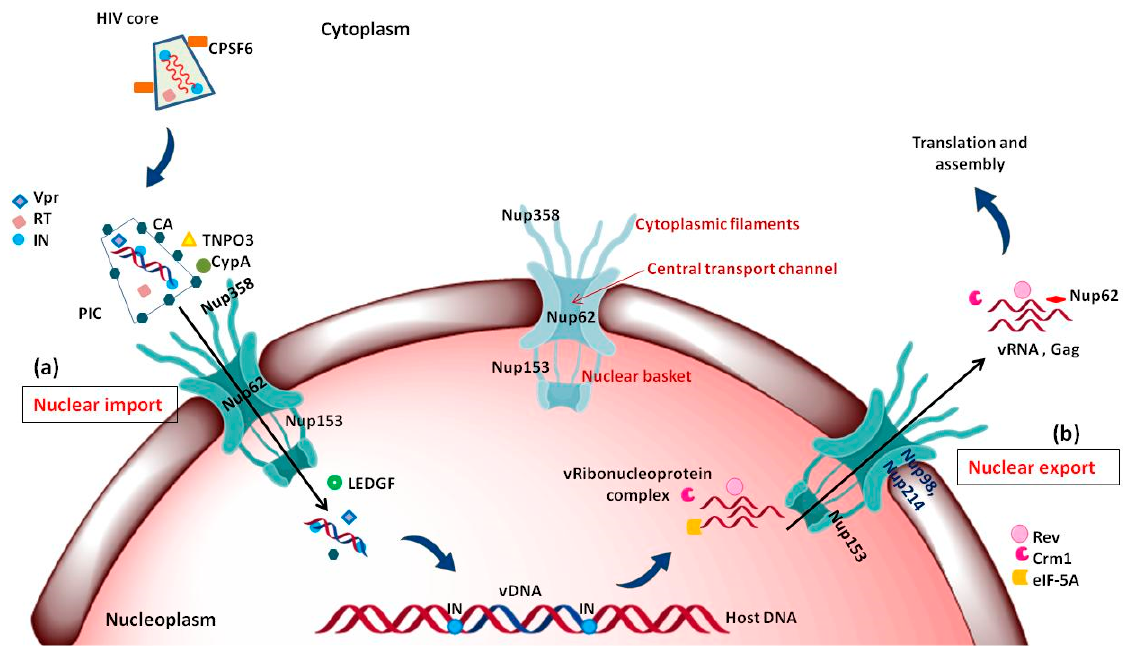
Figure 4. Major events occurring during nuclear import and export of HIV-1: ( a ) Nuclear import of HIV-1 PIC: CPSF6 interacts with intact HIV core which upon uncoating and reverse transcription forms the PIC. TNPO3, CypA and CypA like domain of Nup358 binds to the left over CA and helps in docking of PIC on the cytoplasmic face of NPC; while Vpr and IN having NLS, interact with Nups like Nup153 which help in import of the PIC into the nucleus. In nucleoplasm, LEDGF is involved in release of PIC from Nup153 and helps in integration of vDNA into the host DNA; ( b ) nuclear export of vRNA-protein complex: The unspliced and partially spliced mRNA need viral accessory protein Rev which interacts with various cellular factors like Crm1, eIF-5A and Nups, such as Nup62, Nup214, Nup98 and facilitate the nuclear export of this viral ribonucleoprotein complex.